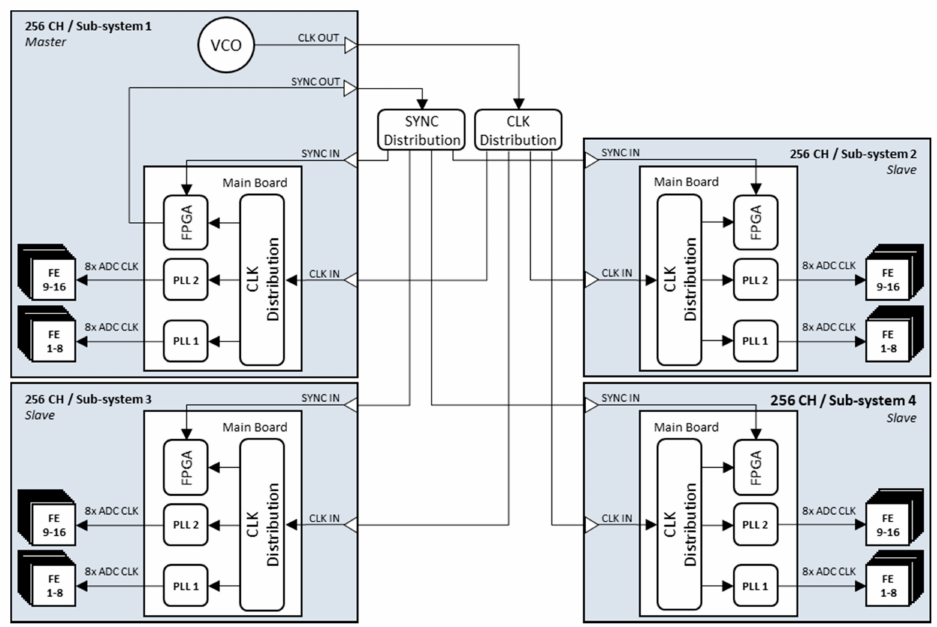
Figure 6. Synchronization scheme with one master and three slave